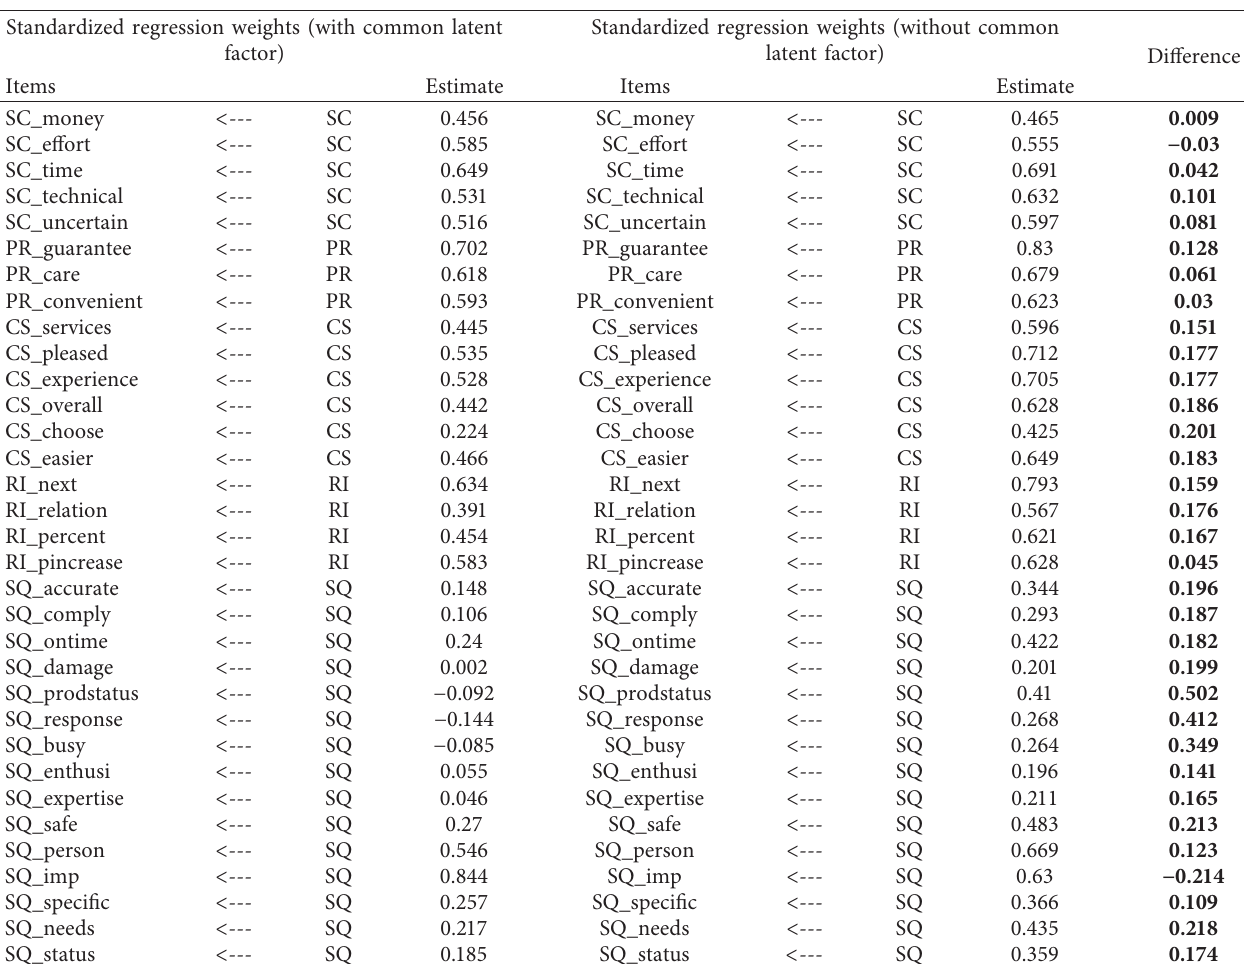
Table 6: Common method bias (CMB) test through common latent factor method. Standardized regression weights (with common latent Standardized regression weights (without common factor)